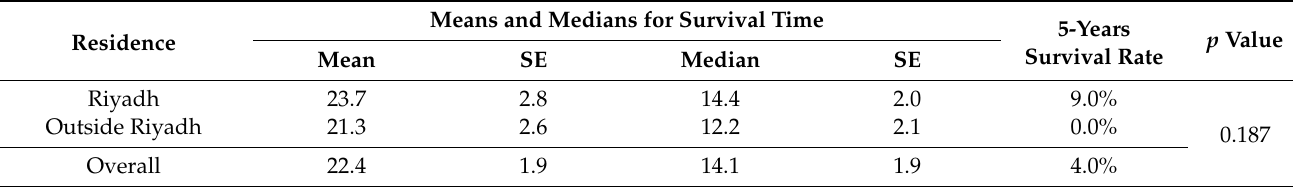
Table 3. Survival rates among patients with GBM, by